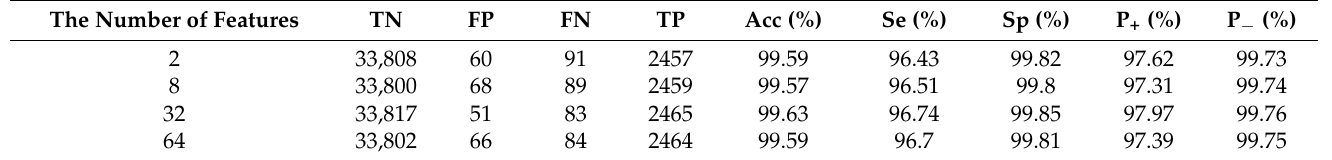
Table 9. The results of the varying number of